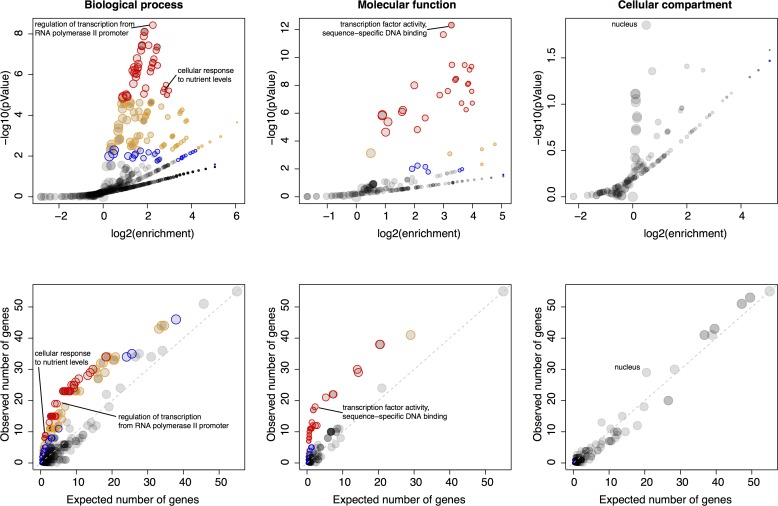
Gene ontology (GO) enrichments of genes located in hotspots.For each major GO category of ‘Biological Process’, ‘Molecular Function’, and ‘Cellular Compartment’, the figure shows two panels. The most significant GO term as well as GO terms discussed in the main text are indicated. Top panels: Relationship between strength (x-axis) and significance (y-axis) of the GO enrichment. Each GO term is plotted as a dot, with size scaled as a function of the number of terms in the GO group. Note how the relationship between enrichment strength and significance depends on GO category size. Different levels of significance are indicated by colored circles. With decreasing stringency, these colors indicate: Red: p<0.05 after Bonferroni correction for the number of GO terms tested; Orange: permutation-based p<0.005, corresponding to an FDR of 5% (Materials and methods), Blue: GO term specific permutation-based p<0.01. Bottom panels: The number of genes in each GO term expected to be significant based on GO category size (x-axis) vs. the number of genes in each GO term observed to be significant. Color codes are as in the top panels. The diagonal line indicates observations that match the expectation.